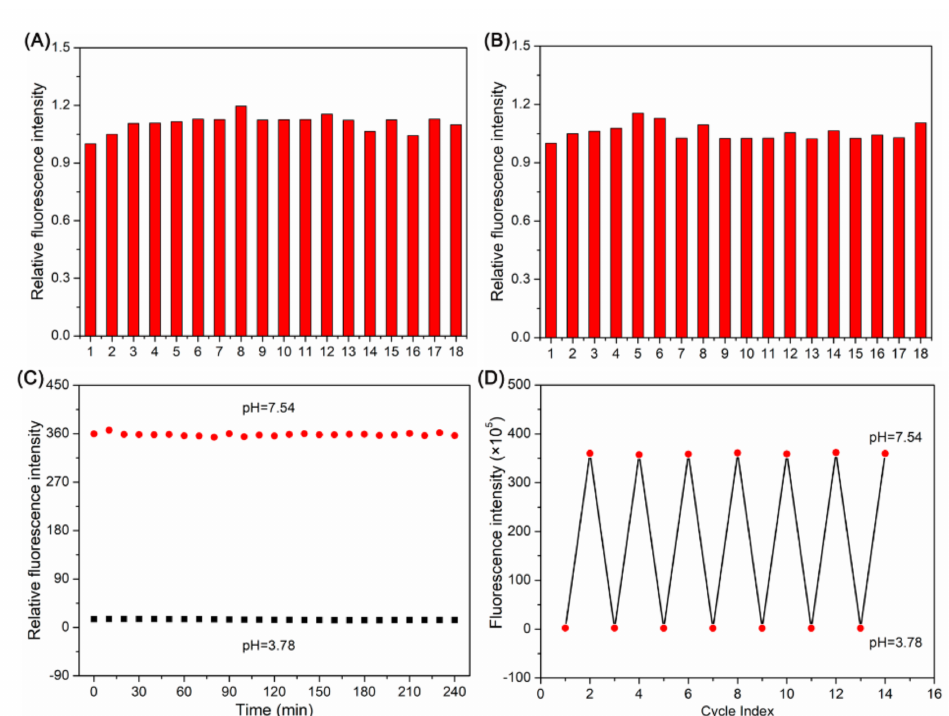
Figure 2. Fluorescence responses of BP (10 µ M, 1) at 630 nm in the presence of different metal ions and biologically relevant species at pH were 3.78 ( A ) and 7.54 ( B ). 2. Na + (200 µ M), 3. K + (200 µ M), 4. Ca 2+ (200 µ M), 5. Mg 2+ (50 µ M), 6. Ni 2+ (50 µ M), 7. Co 2+ (50 µ M), 8. Mn 2+ (50 µ M), 9. Zn 2+ (50 µ M), 10. Al 3+ (50 µ M), 11. Cu 2+ (50 µ M), 12. Fe 3+ (50 µ M), 13. Cys (50 µ M), 14. GSH (50 µ M), 15. Glu (50 µ M), 16. Arg (50 µ M), 17. H 2 O 2 (50 µ M), 18. ClO - (50 µ M). λ ex = 590 nm. ( C ) The time dependent of the fluorescence intensity of BP (10 µ M) in B-R buffer with 50% MeCN at pH was 3.78 and 7.54. ( D ) The fluorescence reversibility of BP (10 µ M) in B-R buffer with 50% MeCN